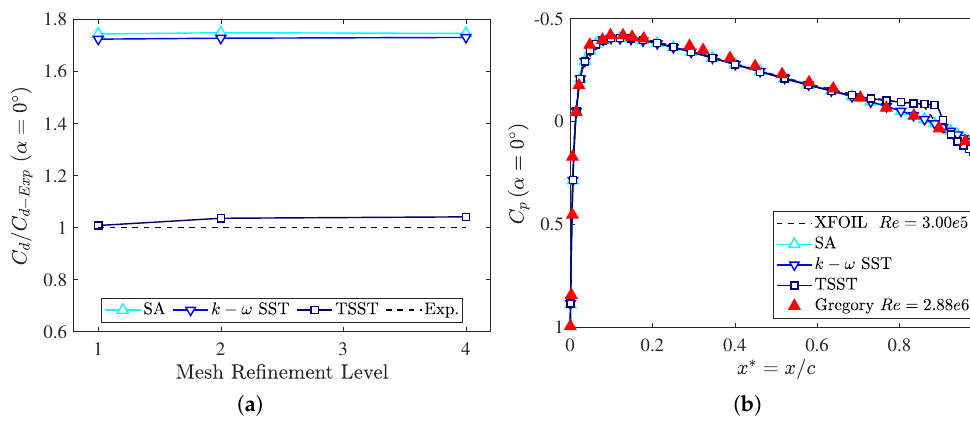
Figure 7. Two-dimensional model validation. ( a ) Comparison between the experimental and the CFD- computed drag coefficient of the undamaged NACA 0012 airfoil as a function of the turbulence model and the mesh refinement level; ( b ) Pressure coefficient distribution as a function of the turbulence model obtained using the finest grid. Red triangles denote the pressure coefficient experimentally acquired by Gregory and O’Reilly [57]. Single curve reported being the flow